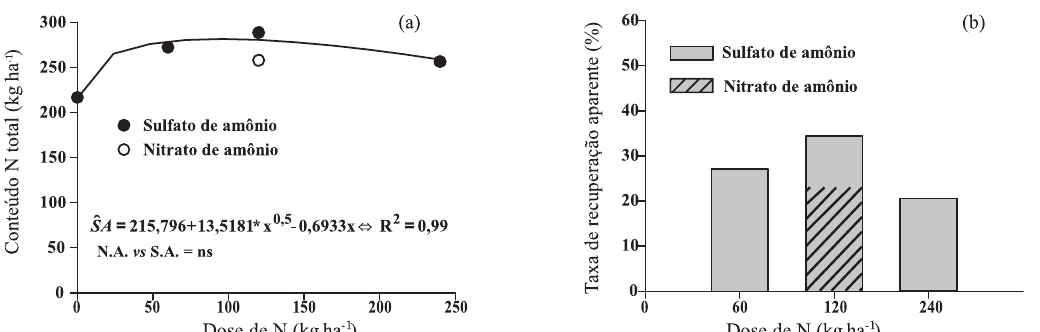
Figura 3. conteúdo de n na parte aérea + serapilheira (a) e taxa de recuperação aparente do n do ferti- lizante (b) de um plantio do clone aec1528 ® de eucalipto, aos 30 meses de idade, influenciados por doses de n aplicado como sulfato de amônio (s.a.) e contraste entre sulfato de amônio e nitrato de amônio, na dose de 120 kg ha -1 . *, ns: significativo a 5 % e não significativo até 10 %, respectivamente, pelo teste